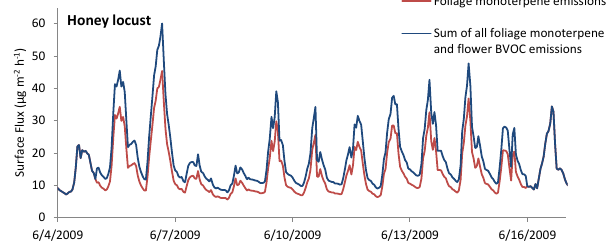
Fig. 10. Modeled sum of monoterpenes (MT) emitted from foliage (using default MEGAN emission rates; red trace) as well as mod- eled floral emissions of MT + other BVOC for the City of Boulder (green trace) based on the measurements conducted in the present study during spring 2009.